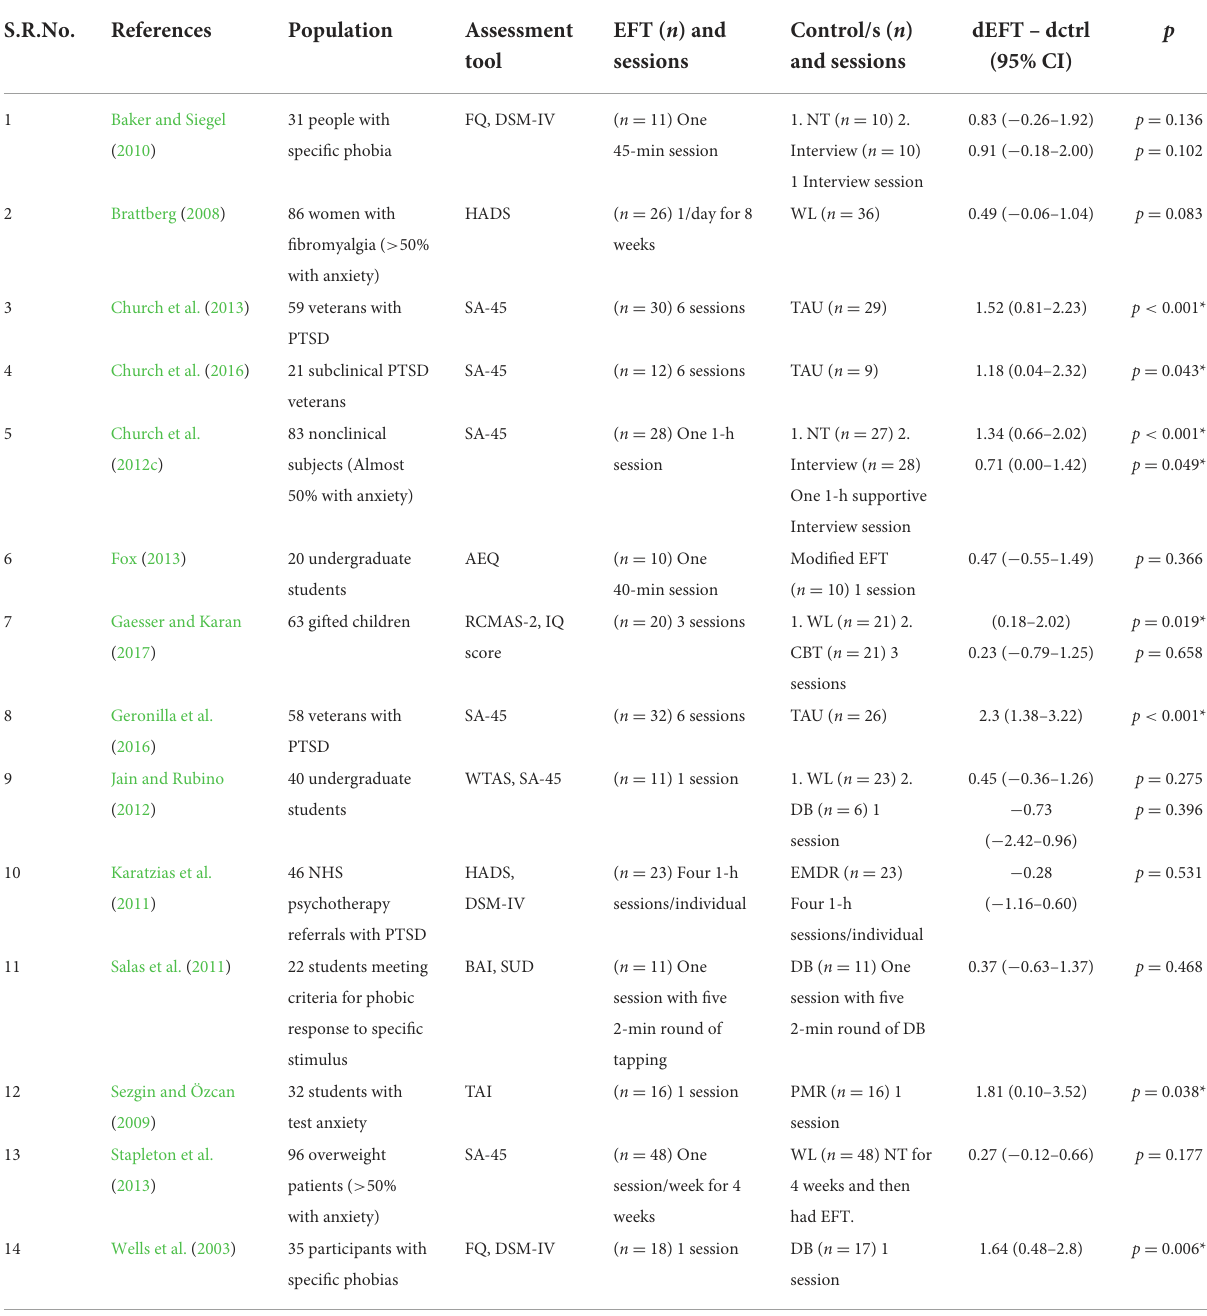
TABLE 2 Anxiety RCTs included in Clond (2016) meta-analysis.